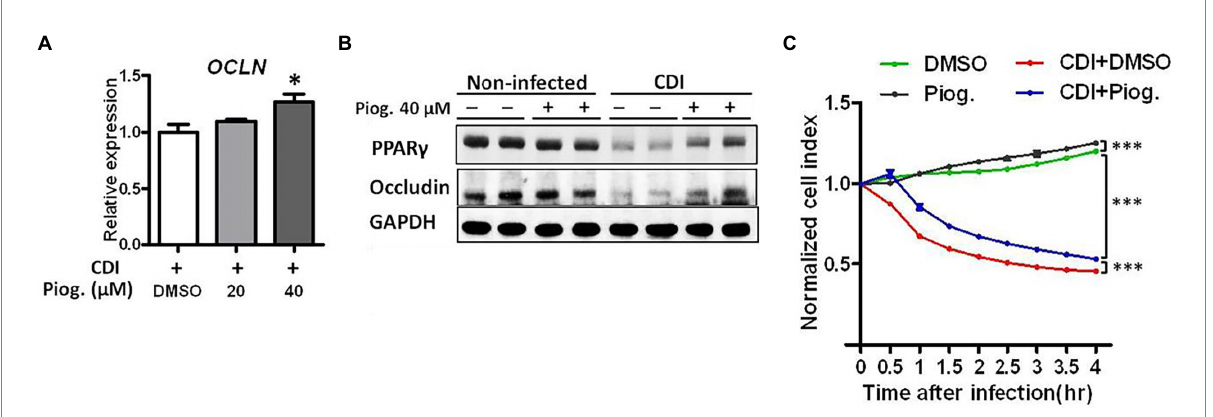
FIGURE 5 Pioglitazone ameliorated CDI-induced barrier dysfunction in C. difficile -infected HT-29 cells. Different dosages of pioglitazone are administered to HT-29 cells 24 h before infection with C. difficile . (A) The mRNA expression levels of occludin in HT-29 cells were measured by real-time PCR under C. difficile infection with or without pioglitazone administration. (B) Western blot analysis of occludin and PPAR- γ protein levels in HT-29 cells with or without C. difficile infection and with or without pioglitazone administration. (C) Using RTCA to measure the cell contact ability altered by C. difficile infection with or without pioglitazone administration. HT-29 cells were treated with 20 μ M pioglitazone or dimethyl sulfoxide (DMSO) 1 h before CDI. Pioglitazone was dissolved in DMSO, and the same concentration of DMSO was used in the control group. Values are expressed as mean ± SEM ( * , p < 0.05; *** , p < 0.001 relative to control group). All data are representative of three independent